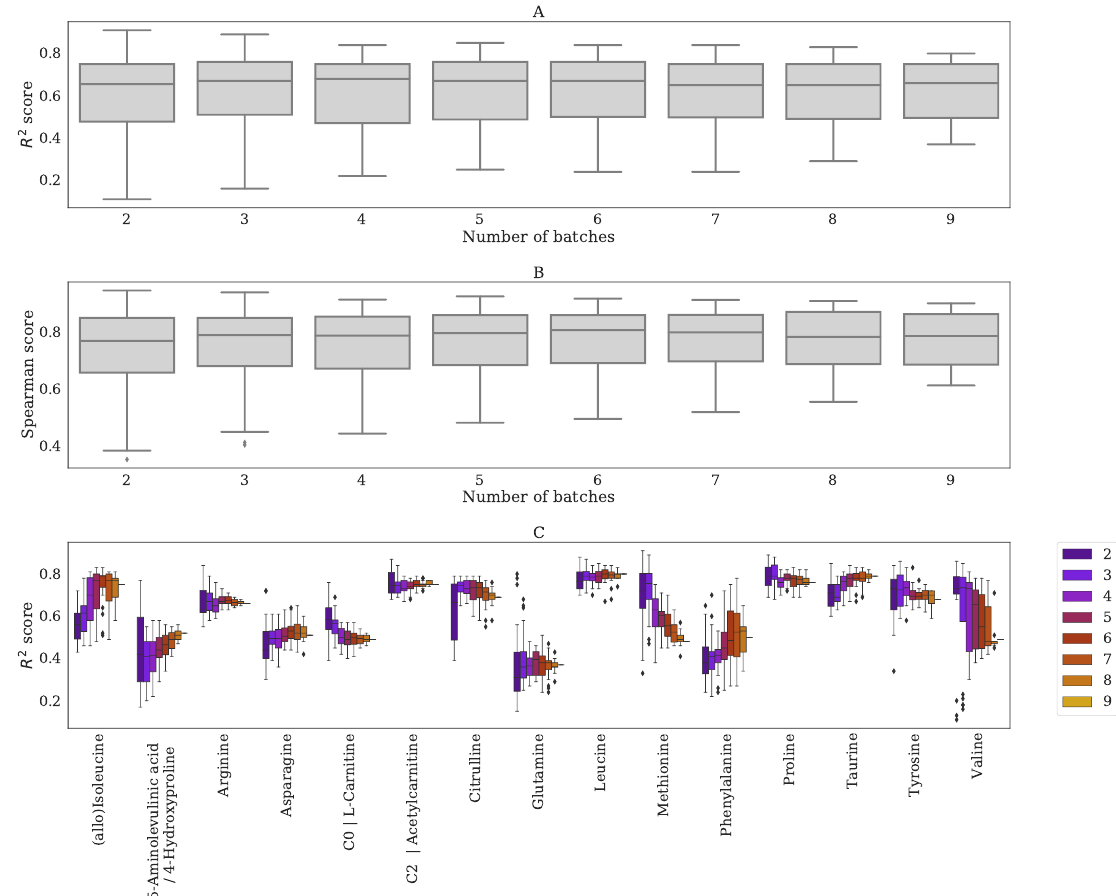
Figure A5. Performance of normalization based on a comparison with quantitative measurements for increasing the number of batches with BC-Metchalizer . ( A ) R 2 score ( B ) Spearman score ( C ) R 2 score per metabolite and number of internal standards. The legend indicates how many batches were used for normalization.